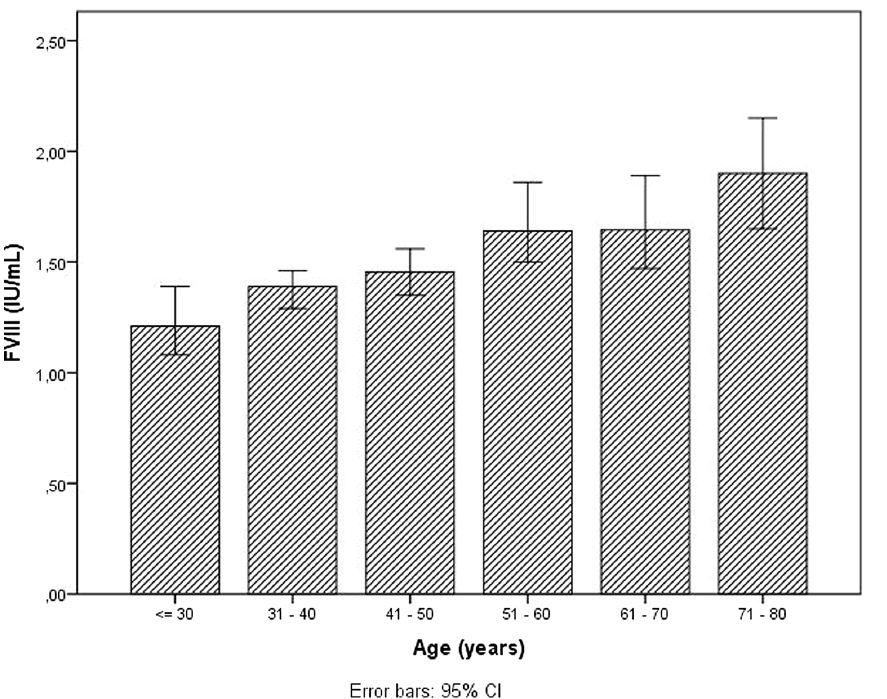
Figure 1. Increase in FVIII levels with regard to the